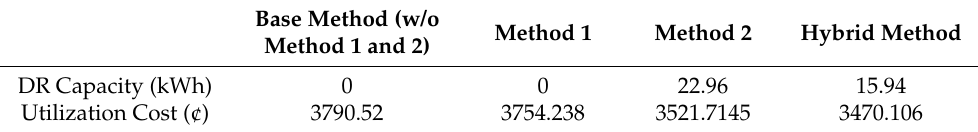
Table 4. Comparison of each operation method.